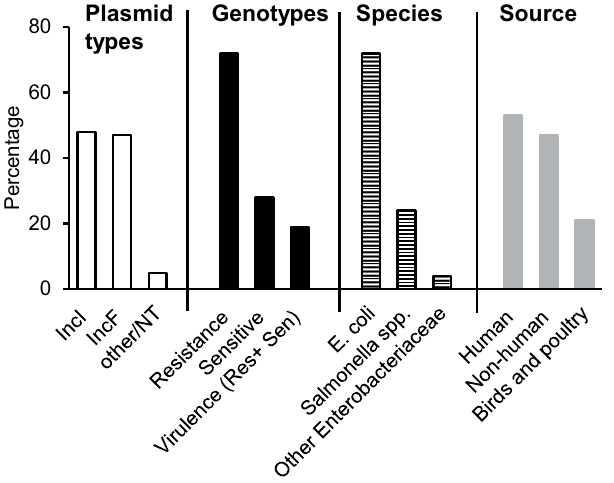
Figure 1. Distribution of the ParDE I TA system in plasmid incompatibility types ( □ ), in antibiotic-resistance (‘resistance’), plasmids without identified antibiotic resistance genes (‘sensitive’) and plasmids identified as “virulence plasmids” ( ■ ); and the bacterial hosts of those plasmids ( ⊟ ) and their sources ( ).